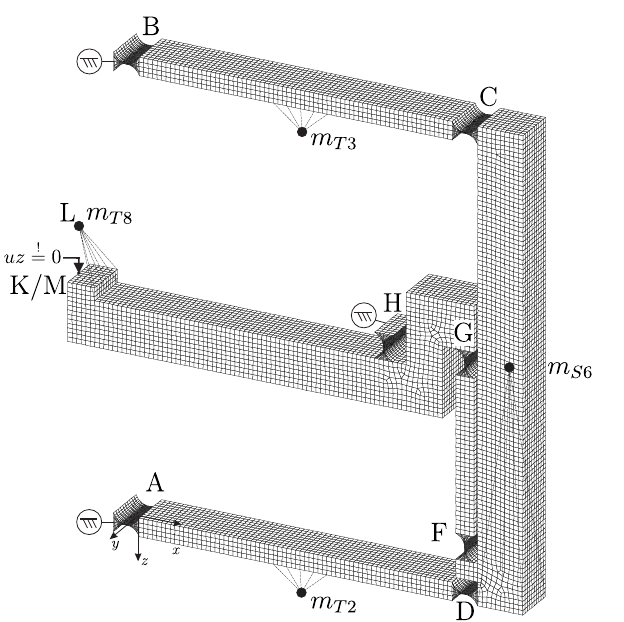
Figure 4. Finite element model of the weighing cell structure with flexure hinges. The point masses attached to the structure are dis- played as • . The contact with the surface nodes is indicated by dashed lines. The displacement constraint is applied to a pilot node connected to the left side of the transmission lever (8) by multi-point